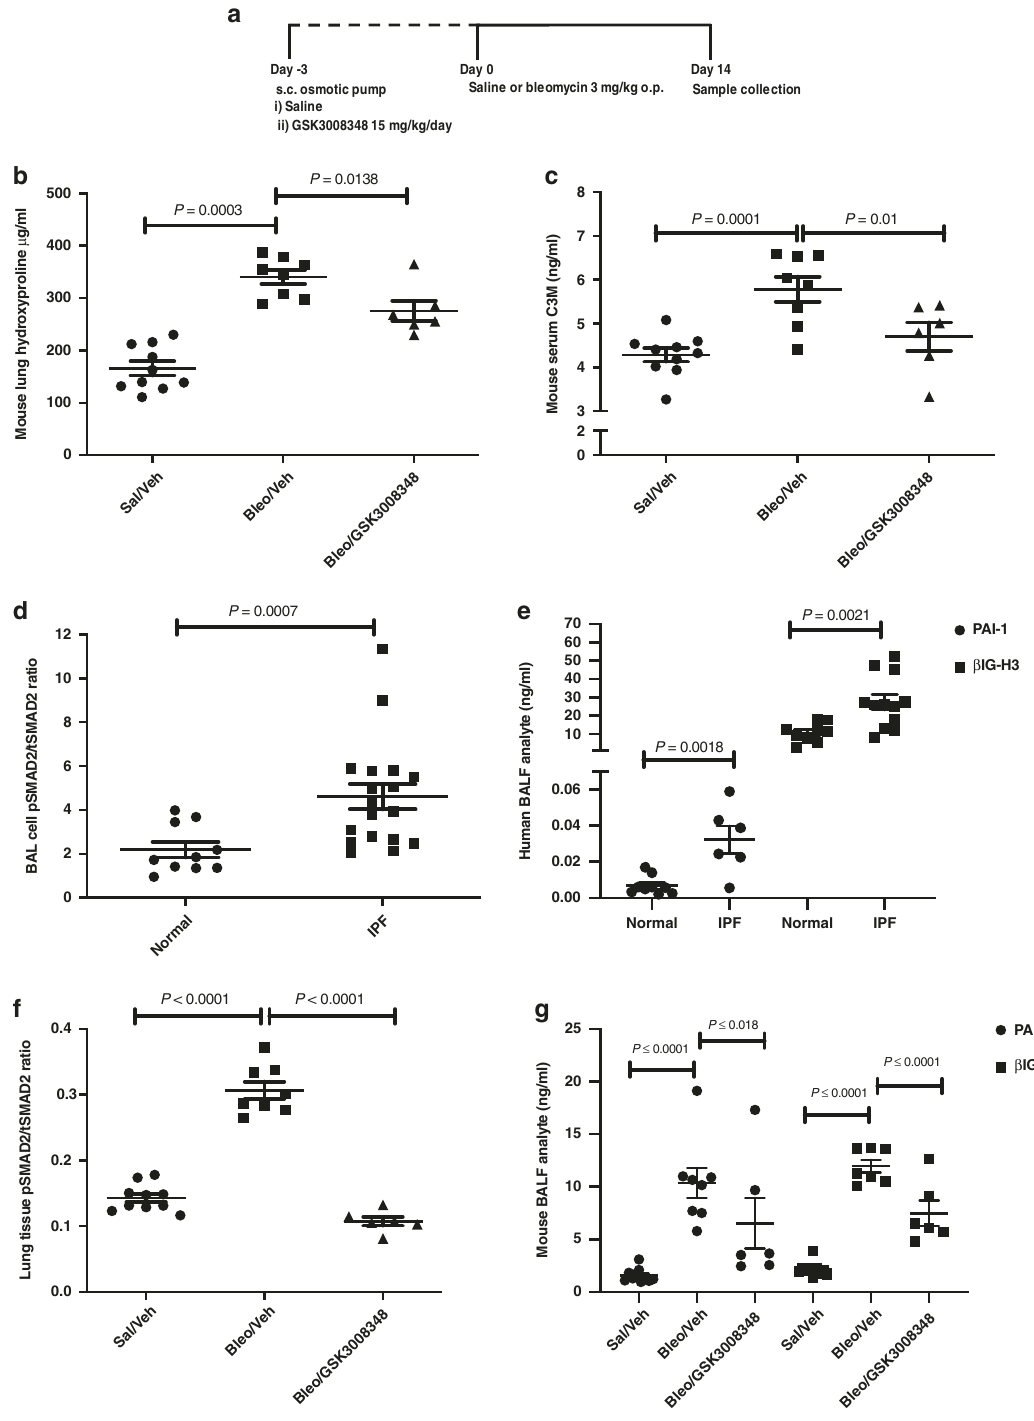
Fig. 6 Translational PD and disease biomarkers from pre-clinical to clinical samples. a Mice were treated with GSK3008348 prior to bleomycin challenge and the effect of GSK3008348 on the b collagen biomarkers hydroxyproline and c C3M in lung tissue (mean ± SEM; n = 6 – 10 animals per group). Levels of pSmad2 in d BAL cells and e β IG-H3, PAI-1 BAL fl uid d in normal and IPF patient populations (mean ± SEM; 6 – 18 donors). The effect of GSK3008348 on PD biomarkers of TGF β -activation in f lung tissue (pSmad2) and g BALF ( β IG-H3 and PAI-1) in bleomycin-treated mice (mean ± SEM; n = 6 – 10 animals per group). All statistical analysis completed by ANOVA with Fisher ’ s LSD post test. Sal/Veh Saline/Vehicle, Bleo/Veh Bleomycin/Vehicle. Source data are provided as a Source Data fi